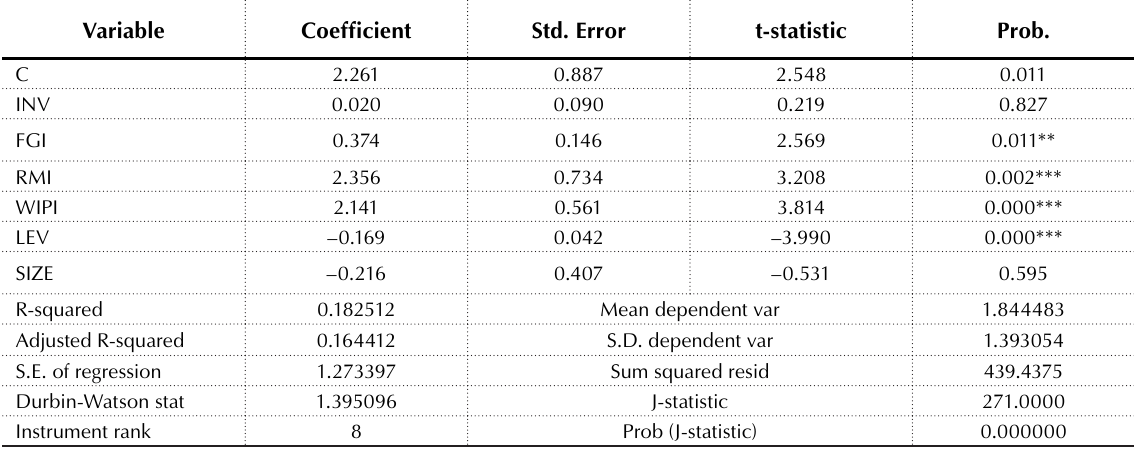
Table 5. Inventory types and firm